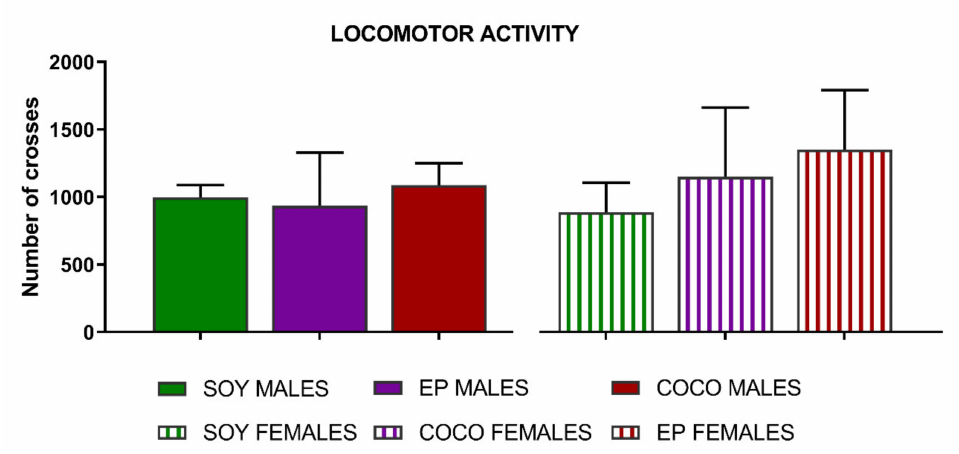
Figure 5. Effects of diet intervention on locomotor activity in the rat. Male and female rats were exposed to AIN-93G diet containing 7% of soybean oil (SOY), or to modified AIN-93G diet containing 3.5% of soybean oil supplemented with 3.5% of coconut oil (COCO) or with 3.5% of evening primrose oil (EP). Locomotor activity was measured as the total number of photobeam crosses in the actimeter and analyzed in males and females separately. Data are presented as mean ± S.D. ( n = 6–13 per group). One-way ANOVA followed by Bonferroni’s multiple